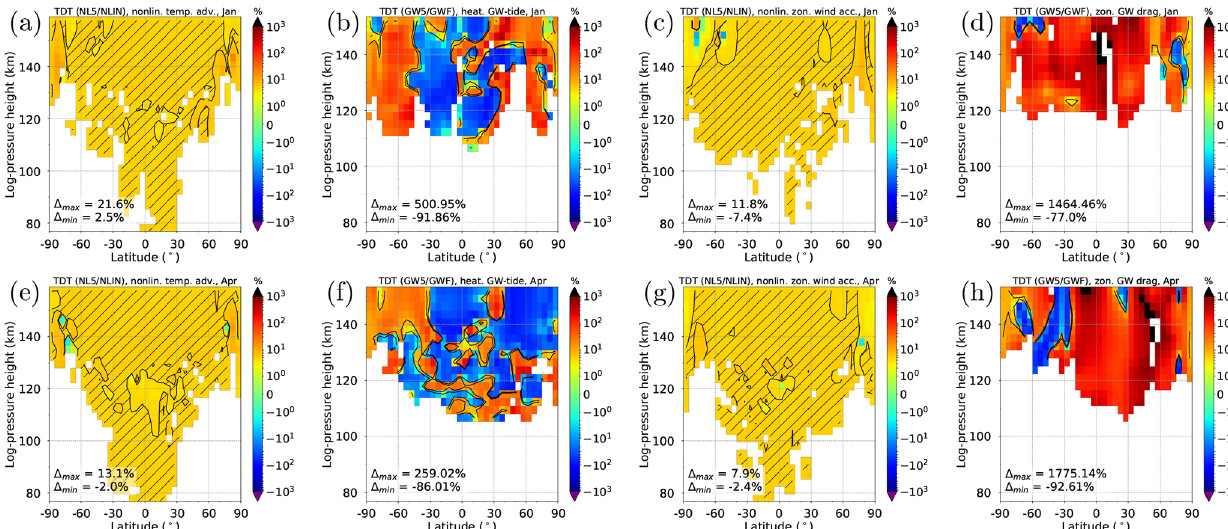
Figure 2. Relative change of terdiurnal forcing terms for an implemented increase of 5% for January (a–d) and April (e–h) . From left to right: nonlinear temperature advection (a, e) , heating due to GW–tide interactions (b, f) , nonlinear zonal wind acceleration (c, g) , and zonal drag due to GW–tide interactions (d, h) . Red (blue) colors refer to a larger forcing in NL5 and GW5 (NLIN and GWF). Hatched areas highlight the values 4.5% ≤ ( NL5 / NLIN − 1 ) · 100 ≤ 5 . 5% and 0% ≤ ( GW5 / GWF-1 ) · 100 ≤ 10%, respectively. Blank areas denote that the respective forcing in NLIN is smaller than 1K (2ms − 1 ), and the respective forcing in GWF is smaller than 1K (10ms − 1 ).